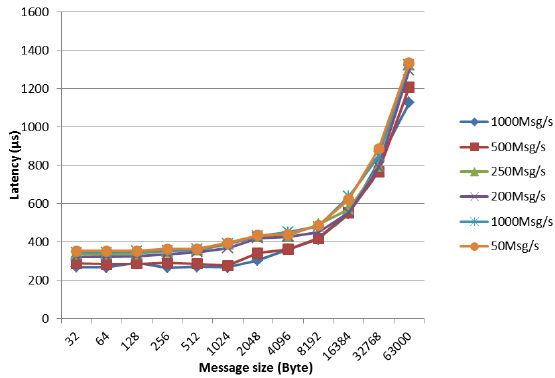
Figure 8. Performance test for DDS multicast and best effort QoS.